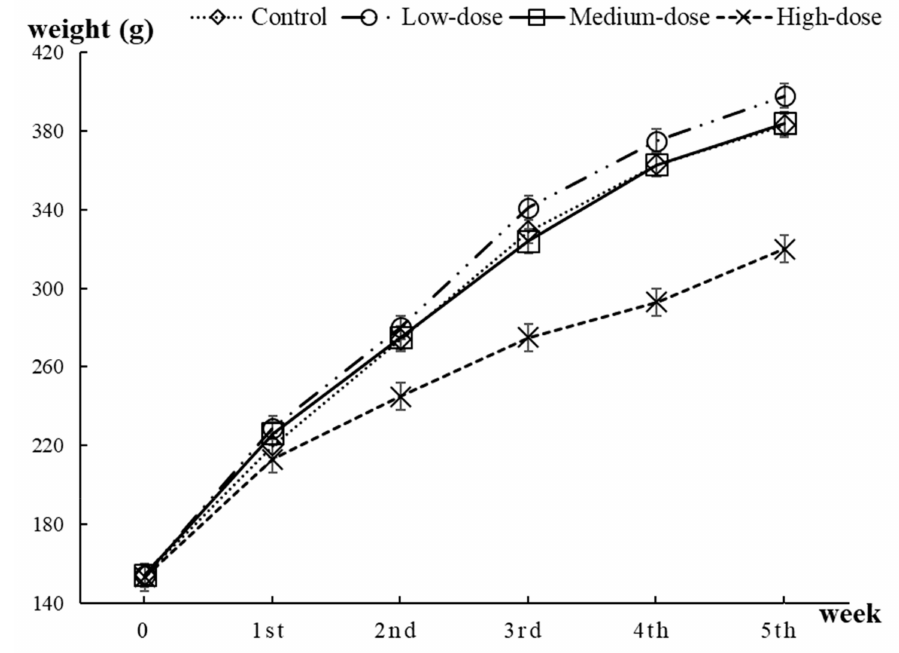
Figure 1. Body weight of Sprague–Dawley (SD) rats with di ff erent doses of rare earth elements